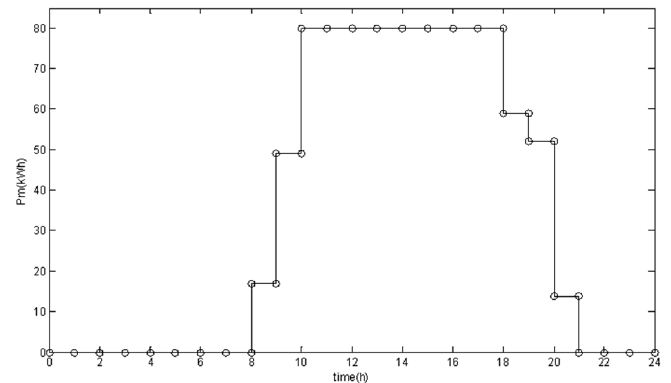
Figure 9. Output power of the micro-turbines.